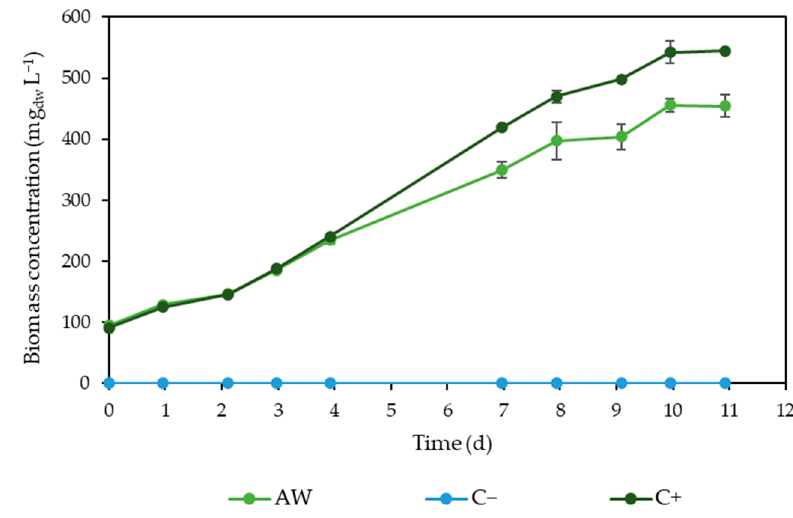
Figure 2. Growth curves of AW, C − and C+ assays.